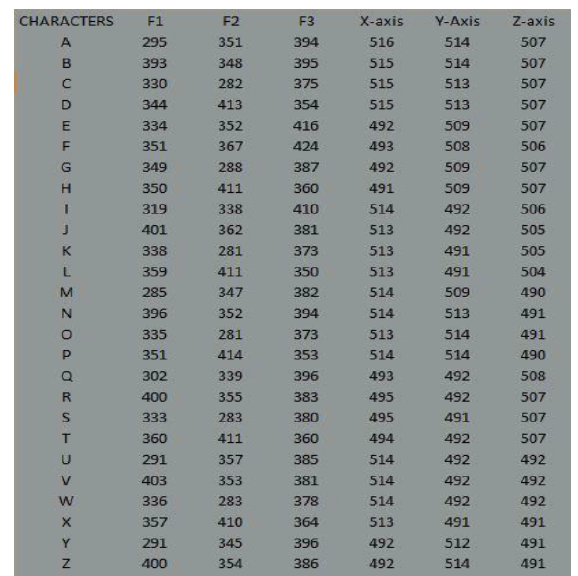
Table 2. Voltage values for